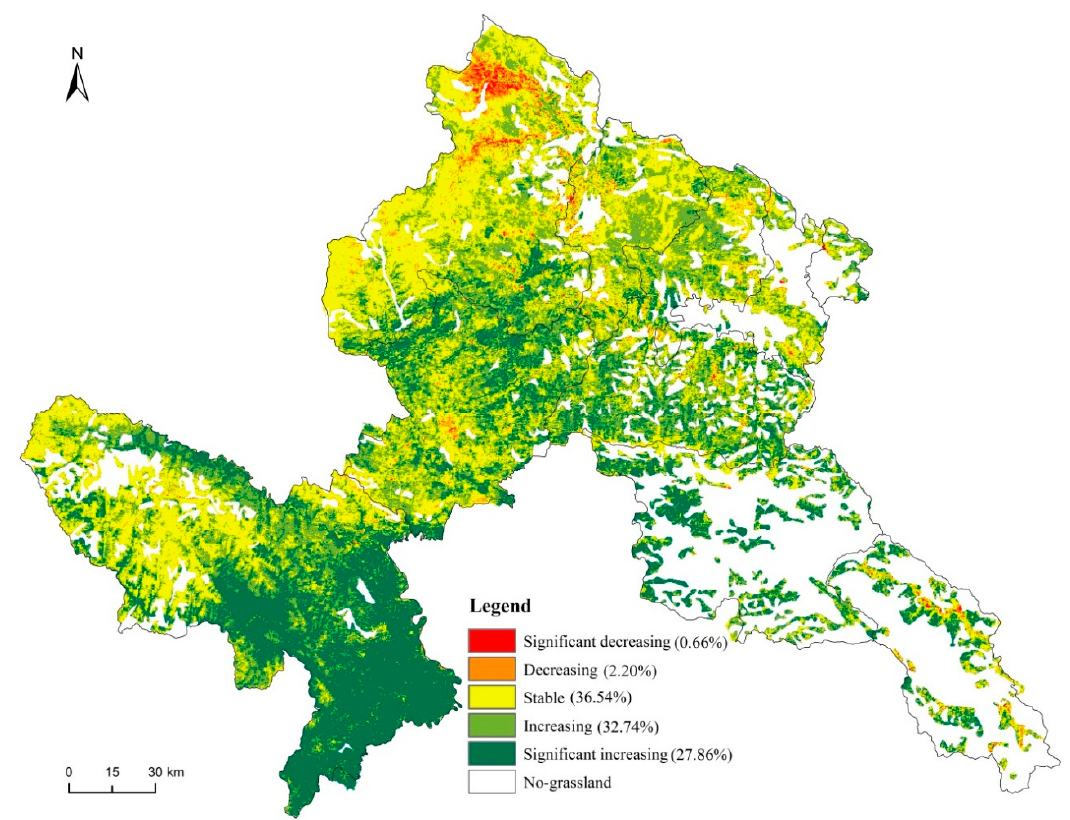
Figure 5. Variation of grassland cover in Gannan Prefecture from 2001 to 2016.